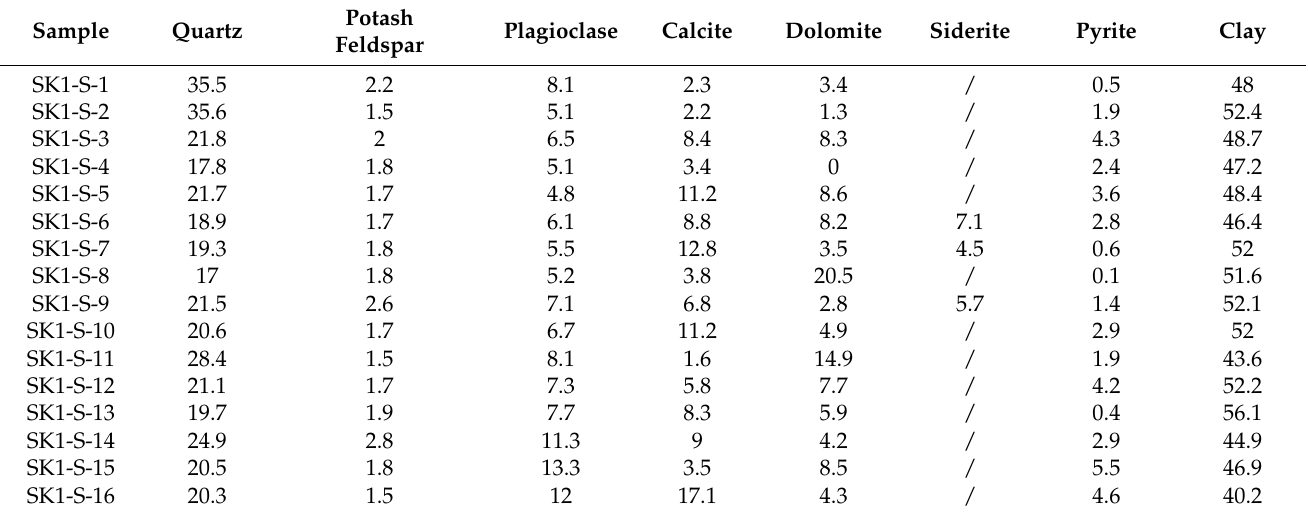
Table 5. Mineral composition of K 2 n 1+2 by XRD (unit: